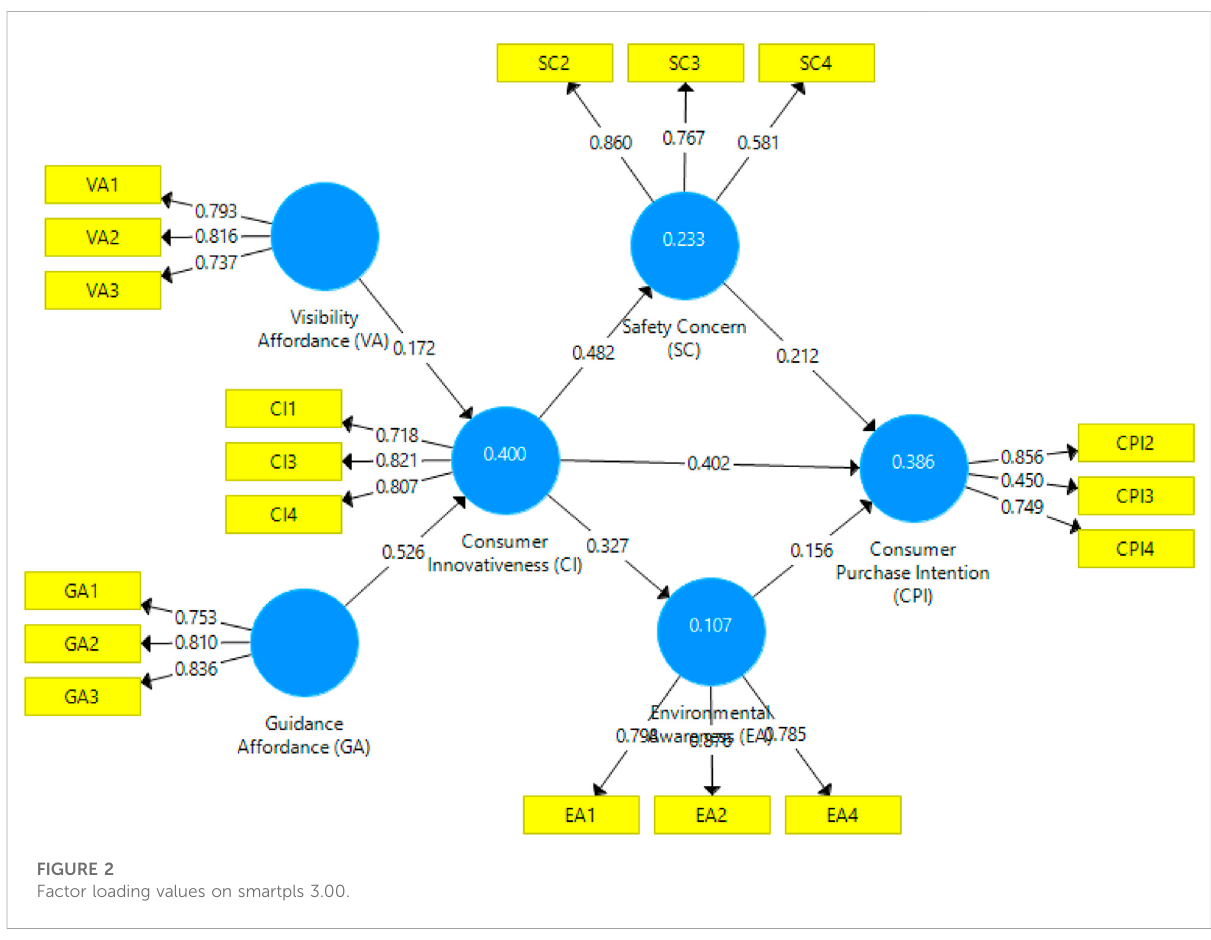
FIGURE 2 Factor loading values on smartpls 3.00.